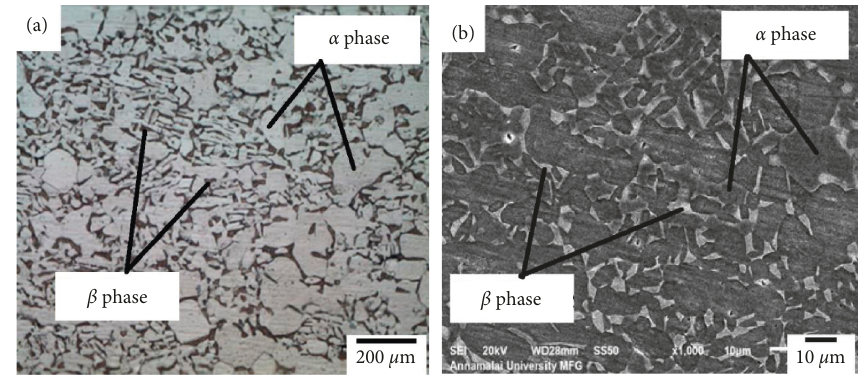
Figure 7: Micrograph of the unwelded Ti6Al4V alloy: (a) optical; (b) SEM.